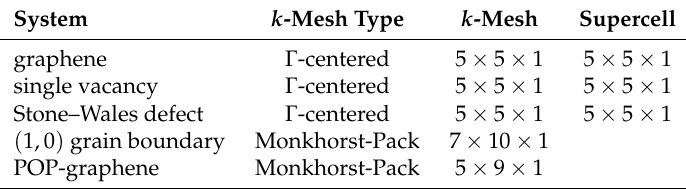
Table 1. k -meshes used for sampling the Brillouin